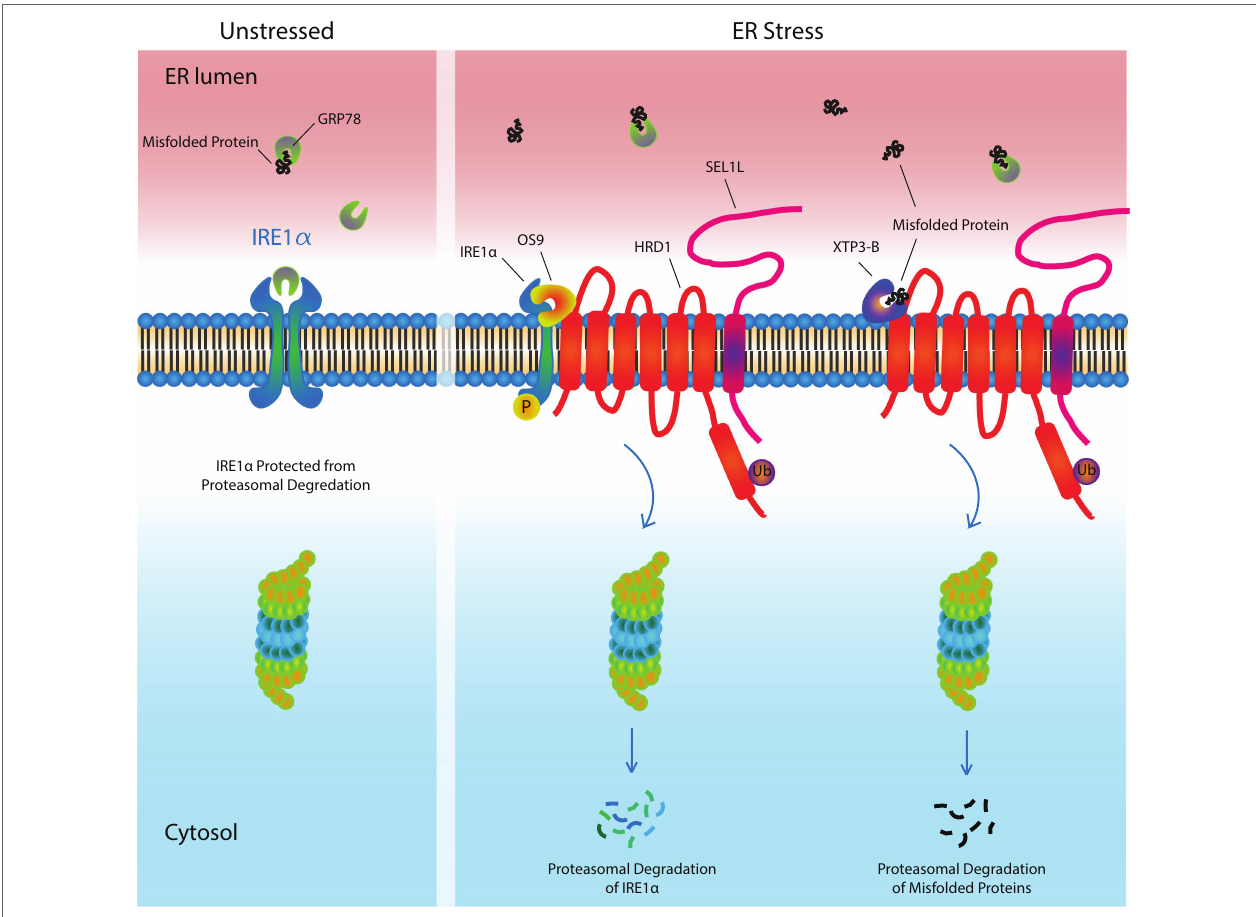
FIGURE 2 | ER-Associated Degradation. Under unstressed conditions, the UPR receptor, IRE1 α , is bound by the UPR ligand and chaperone, GRP78, which maintains it in an inactivate state, while also protecting it from targeted degradation by ERAD machinery. In response to ER stress, GRP78 leaves IRE1 α and preferentially binds misfolded/unfolded proteins, which have accumulated in the ER lumen. This leaves IRE1 α unprotected. OS9 and XTP3-B assist in targeting IRE1 α , as well as misfolded proteins, to the HRD1/SEL1L complex where they undergo ubiquitinylation followed by proteasomal degradation, thereby reducing ER stress. Ub,